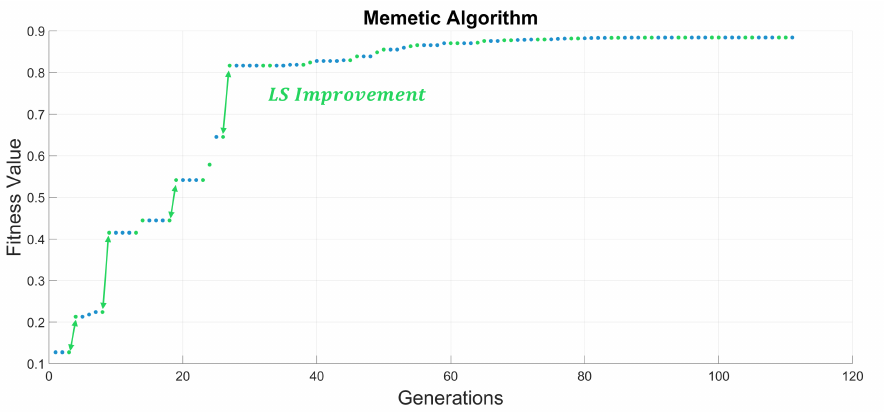
Figure 7. Memetic Algorithm convergence to the optimal solution for an 8-node distribution.